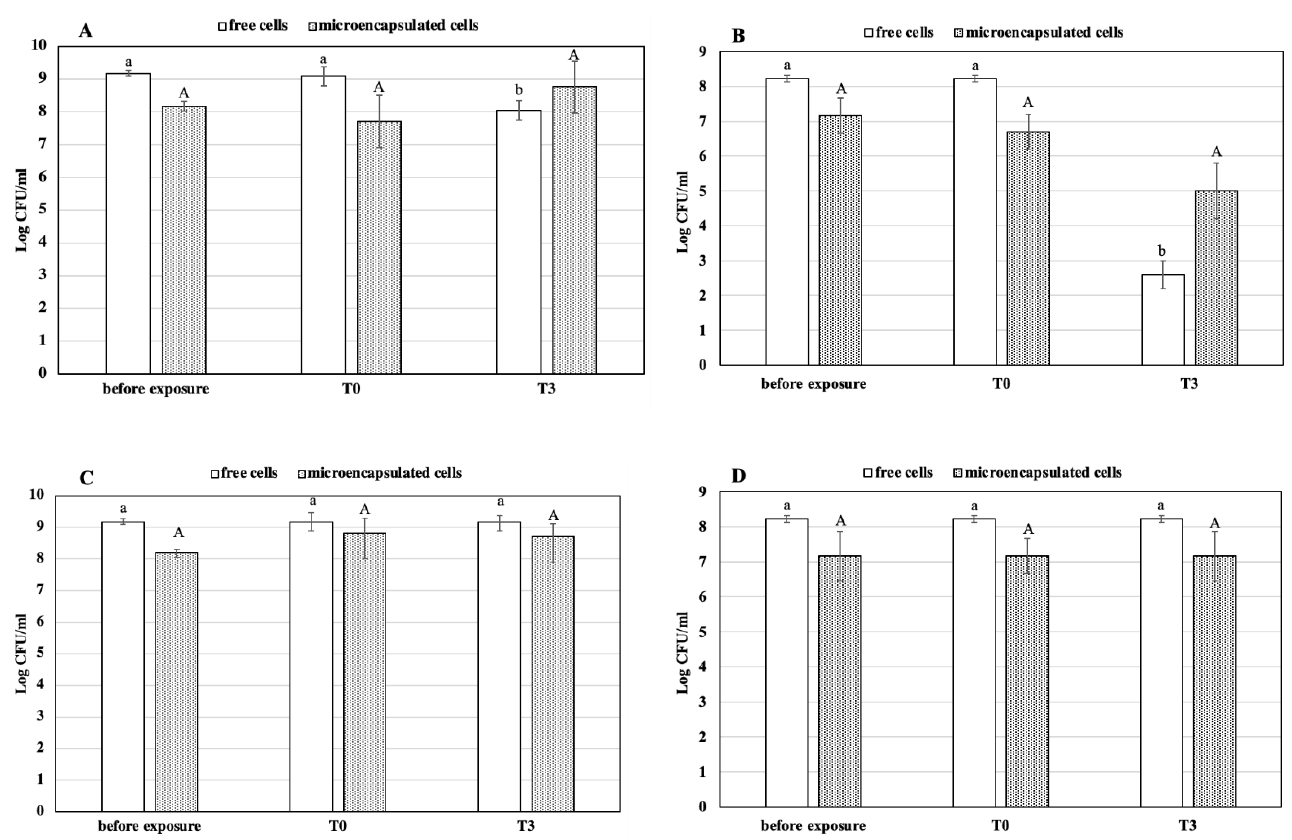
Figure 3. Cell survival of free and microencapsulated cells of L. reuteri DSM 17938 (panels A , C ) and L. plantarum 48M (panels B , D ) after simulated gastric (panels A , B ) and intestinal (panels C , D ) conditions. Values are means of three independent experiments +/ − SD. Different letters (lower for free and capital for encapsulated cells) on the bars indicate significant difference ( p ≤ 0.05) of the mean values between sample before exposure and samples T0 and T3, as a result of t -test.